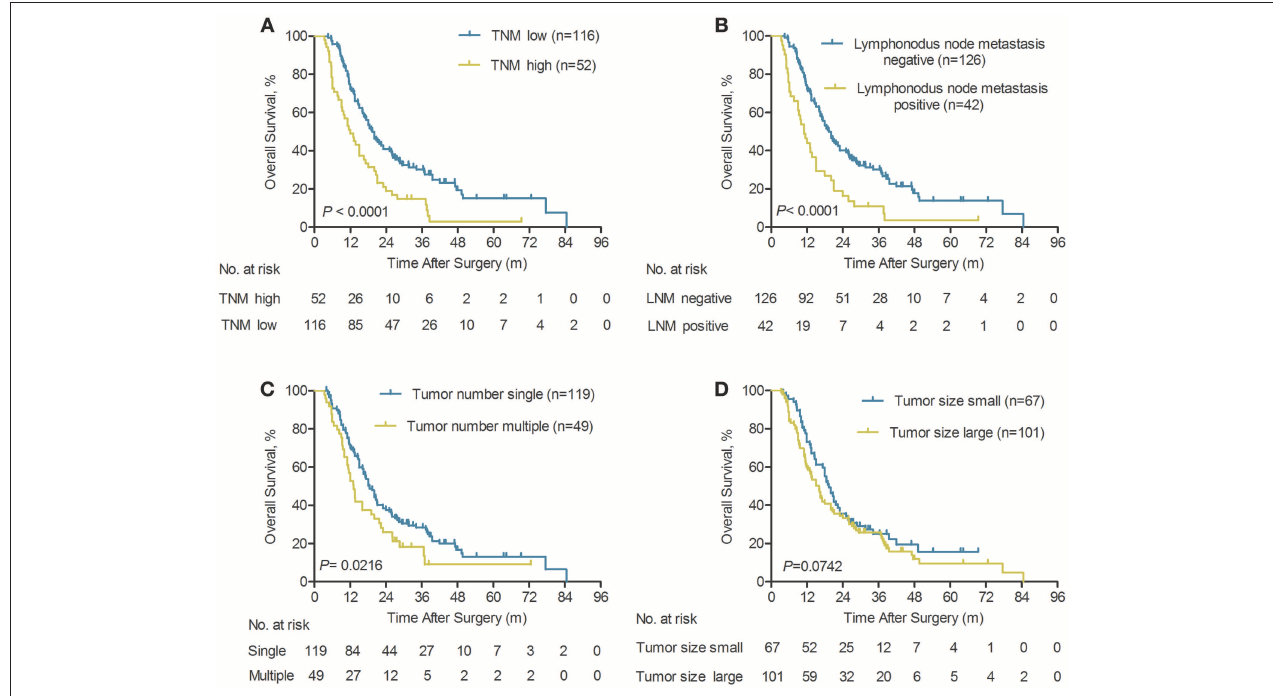
FIGURE 4 | Kaplan-Meier analyses of overall survival rate for ICC patients with early relapse according to the TNM stage, lymphonodus node metastasis (LNM), tumor number, and tumor size. (A) Compared with the TNM high group, OS was significantly higher in the TNM low group ( n = 168), P < 0.0001 (log-rank test). (B) Compared with the LNM positive group, OS was significantly higher in the LNM negative group ( n = 168), P < 0.0001 (log-rank test). (C) Compared with the multiple tumors group, OS was significantly higher in the single tumor group ( n = 168), P = 0.0216 (log-rank test). (D) The overall survival rate was no significant difference between small and large tumor size ( n = 168), P = 0.0742 (log-rank test).